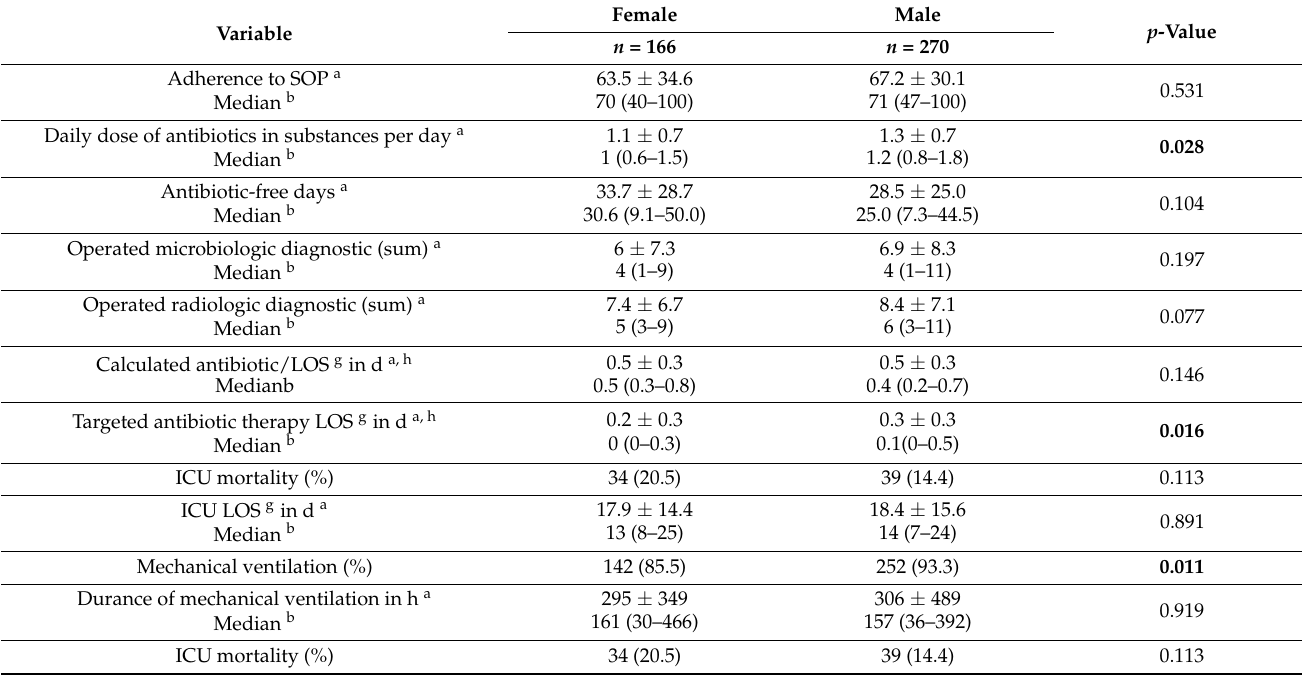
Table 2. Differences of patient-centered care with emphasis on adherence to SOP, antibiotic therapy, mechanical ventilation, microbiologic and radiologic